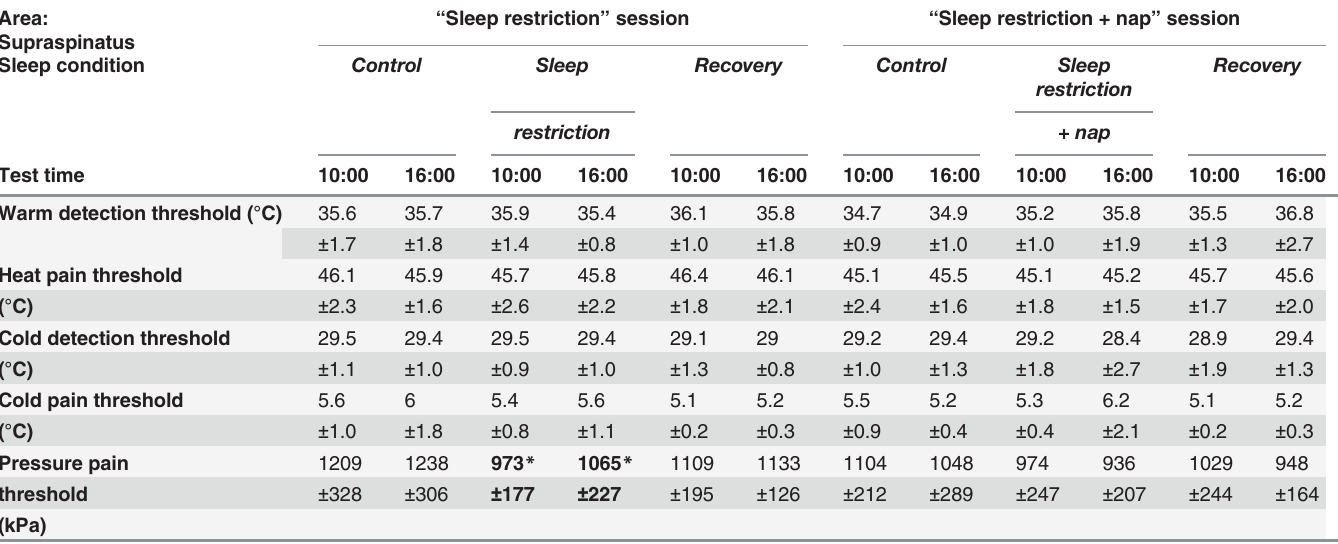
Quantitative sensory testing was performed twice daily, at 10:00 and 16:00, on the supraspinatus area. Warmth and cold detection thresholds, and the thresholds for heat, cold and pressure pain were assessed in control, post-sleep restriction and recovery conditions, in the “ sleep restriction ” and “ sleep restriction + nap ” sessions for each